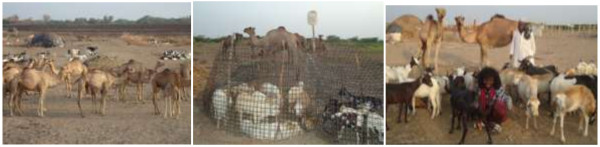
Existing livestock management system in the study areas which allows mixing of small ruminants and camel at different circumstances.